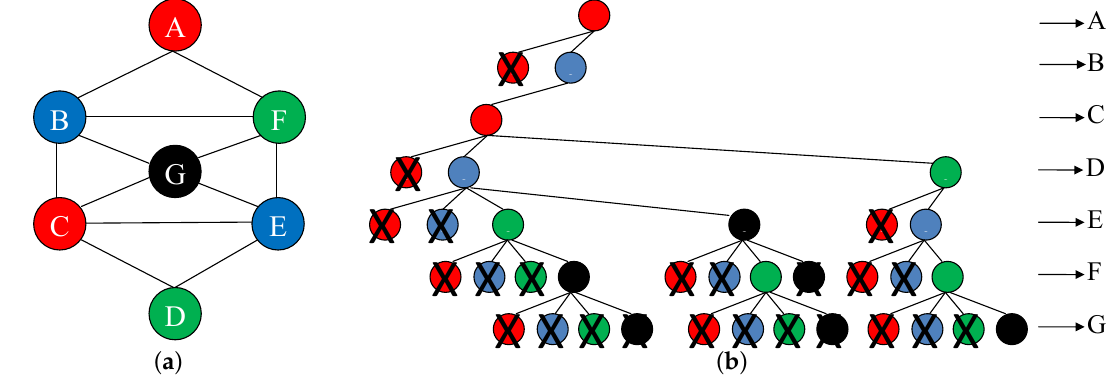
Figure 5. Illustration of ( a ) a seven node planar graph and ( b ) its corresponding backtracking tree for graph